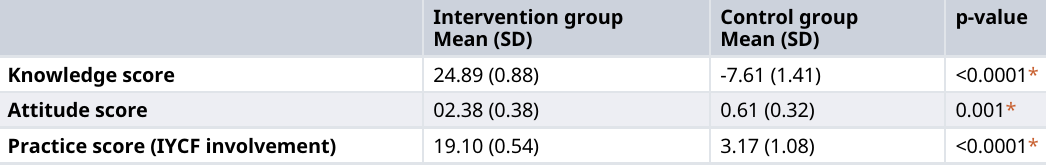
Table 3. Comparison of change scores across the two study groups